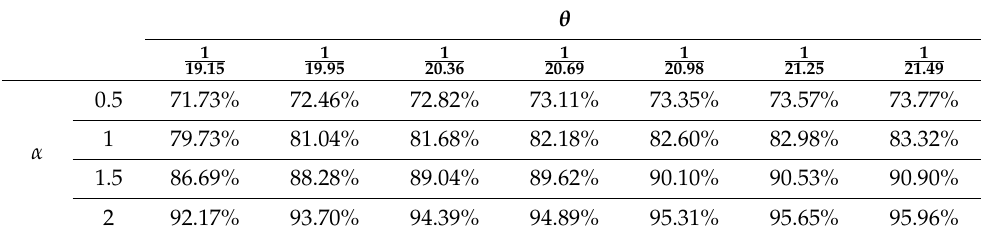
Table 2. Probability that the agent leaves the extractive tasks before a month has passed by.